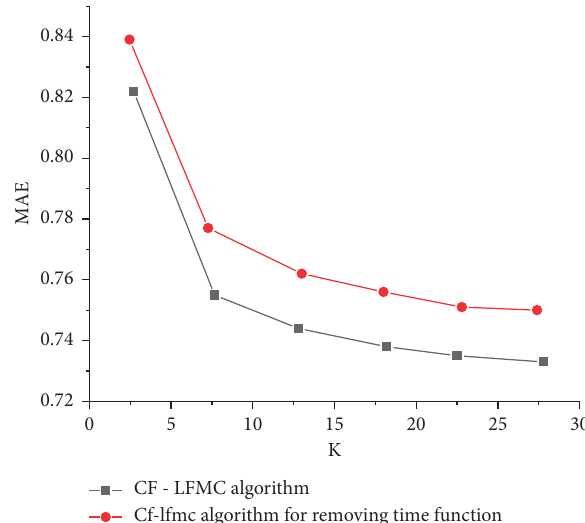
Figure 3: CF-LFMC and cF-LFMC with time function removed vary with the number of nearest neighbors.